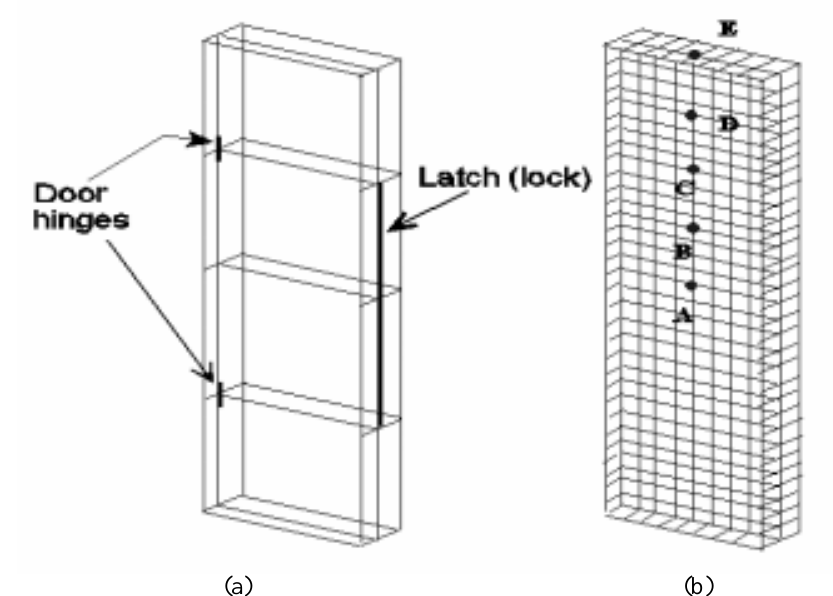
Fig. 7. Single-panel blast door: (a) schematic diagram; (b) finite element